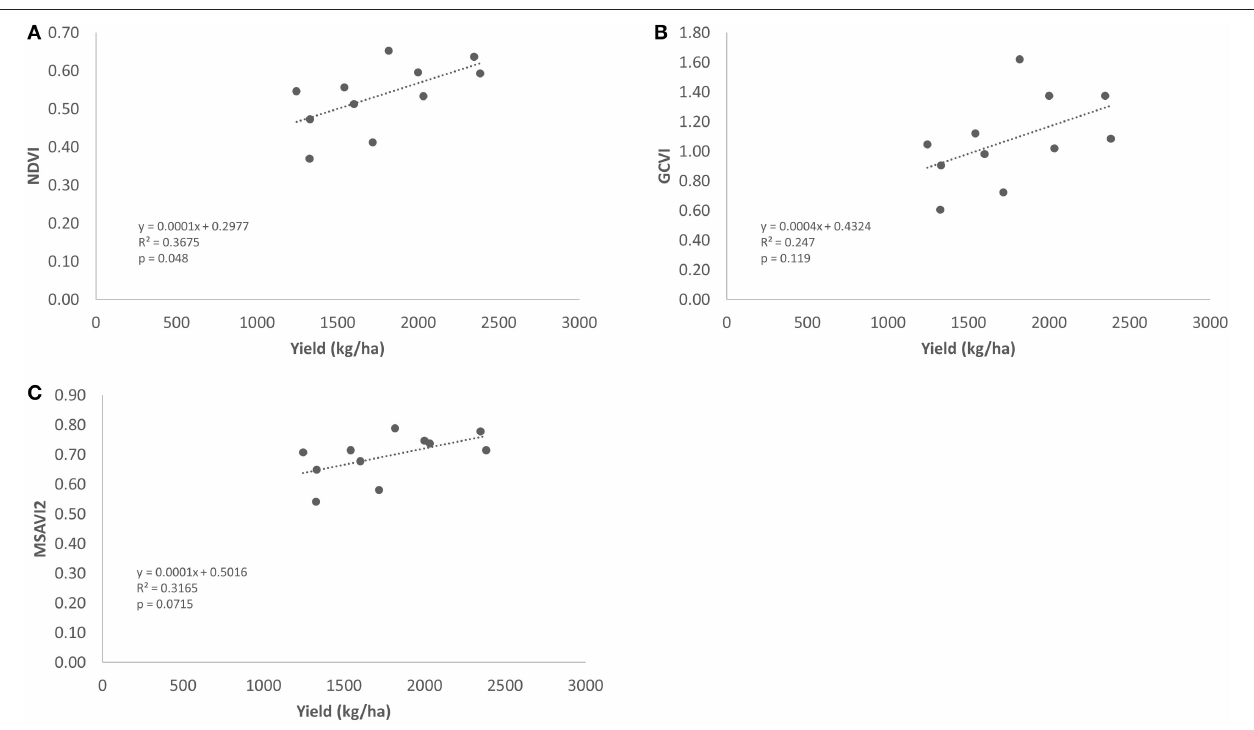
FIGURE 2 | Scatterplots for NDVI (A) , GCVI (B) , and MSAVI2 (C) showing the relationship between the VIs and yield for n